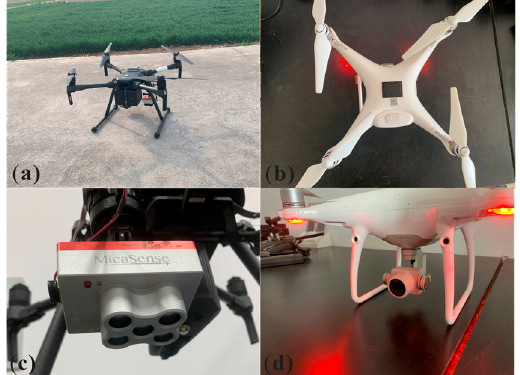
Figure 3. Drones for collecting data. ( a ) DJI M210, ( b ) DJI Phantom 4 Pro, ( c ) Red-Edge MX multi- spectral sensor, ( d ) RGB